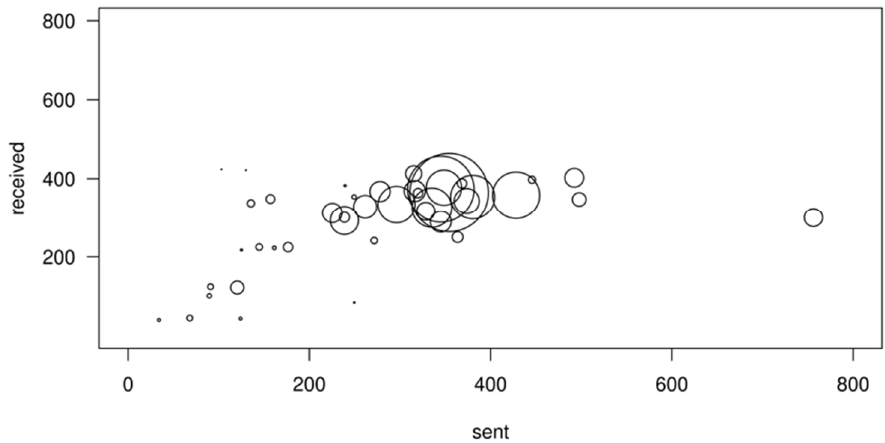
Figure 2. Average number of emails sent and received per person for each department (bubble size is proportional to the number of department members).